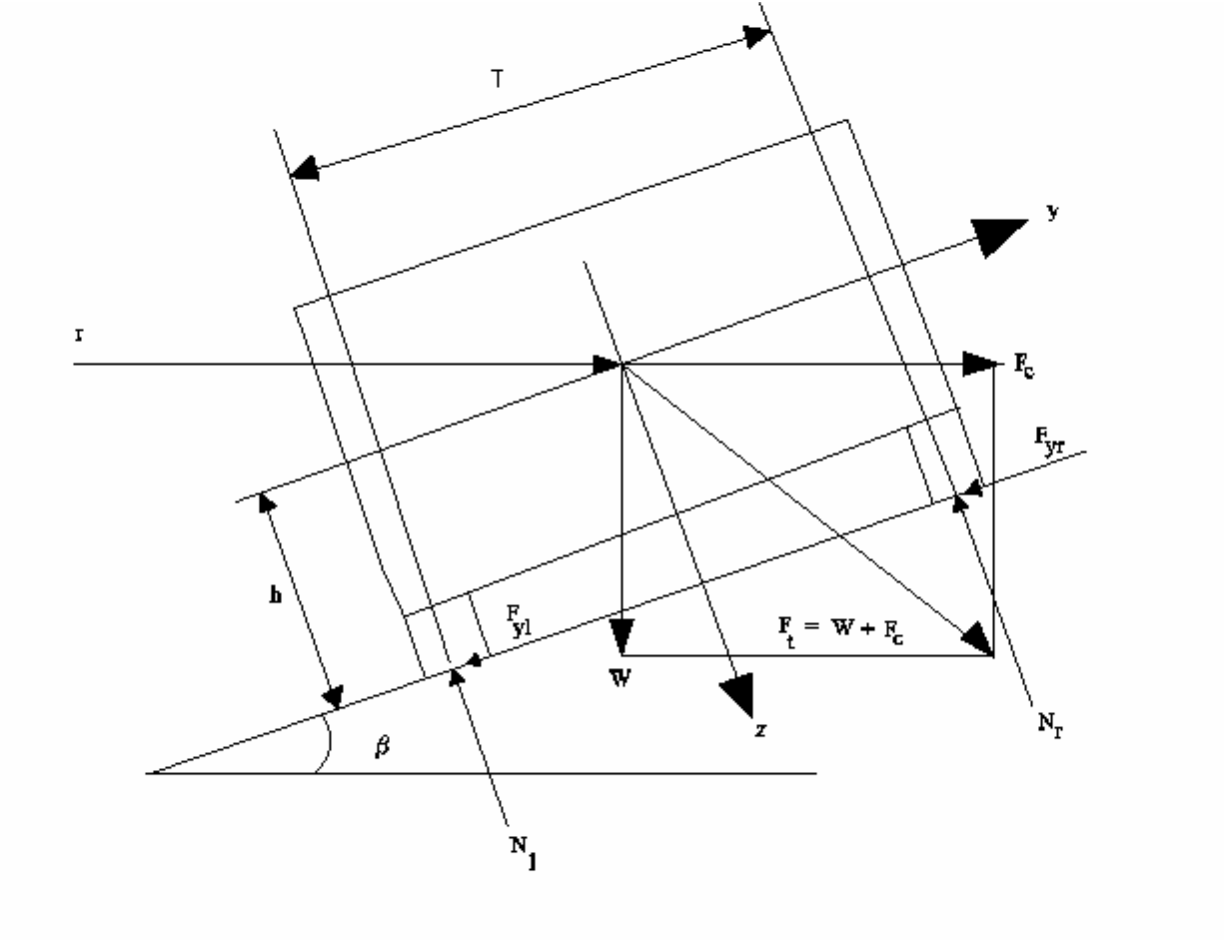
Figure 2. Mechanical model of the